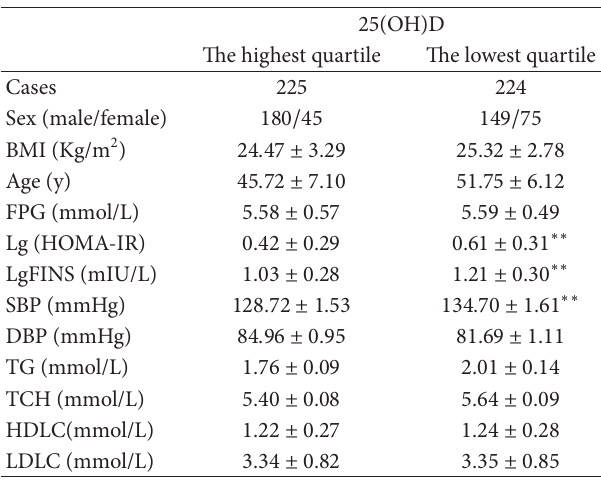
Table 1: Characteristics of the subjects by quartile categories of serum 25(OH)D.